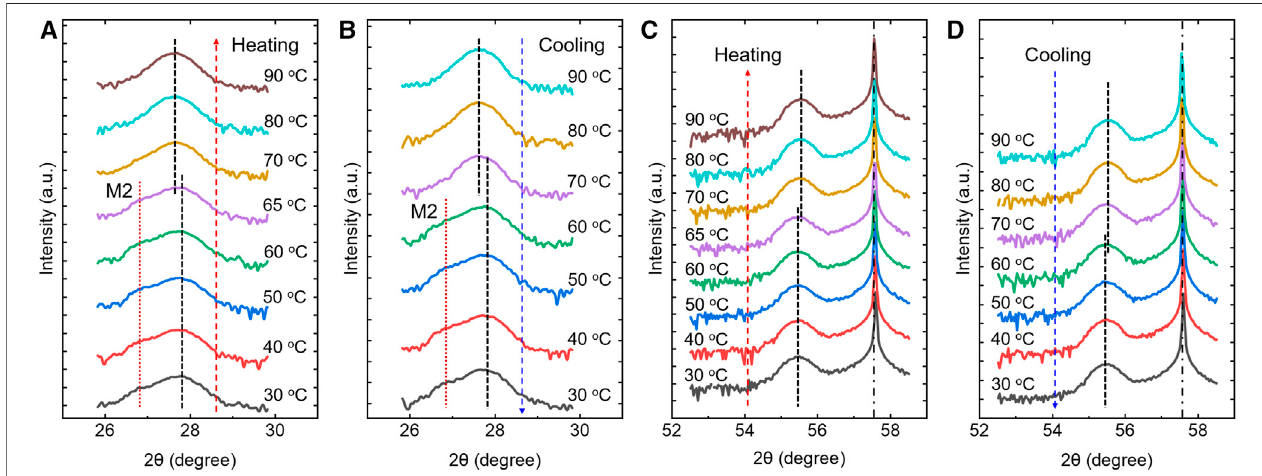
FIGURE 4 | XRD line scans of the VO 2 (011) re fl ections under the (A) heating and (B) cooling processes. The M2 phase at lower temperature disappears with the increase of temperature over the MIT temperature. XRD line scans of VO 2 (220) re fl ections under the (C) heating and (D) cooling processes.